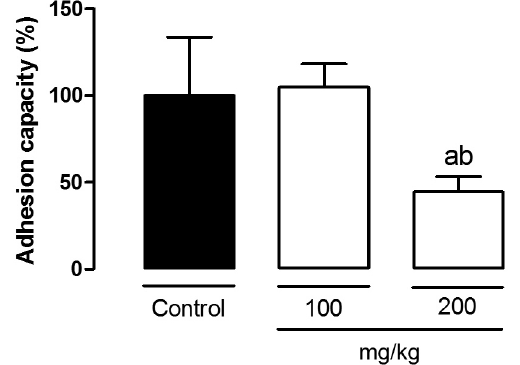
FIGURE 3 - Phagocytic capacity of resident macrophages from mice fed regular chow (Control Group), treated with 100 mg/kg b.w. of CLD (Group 100), and 200 mg/kg b.w. (Group 200). a p<0.001 compared to Control. b p<0.001 compared to Group 100. Results are presented as % relative to